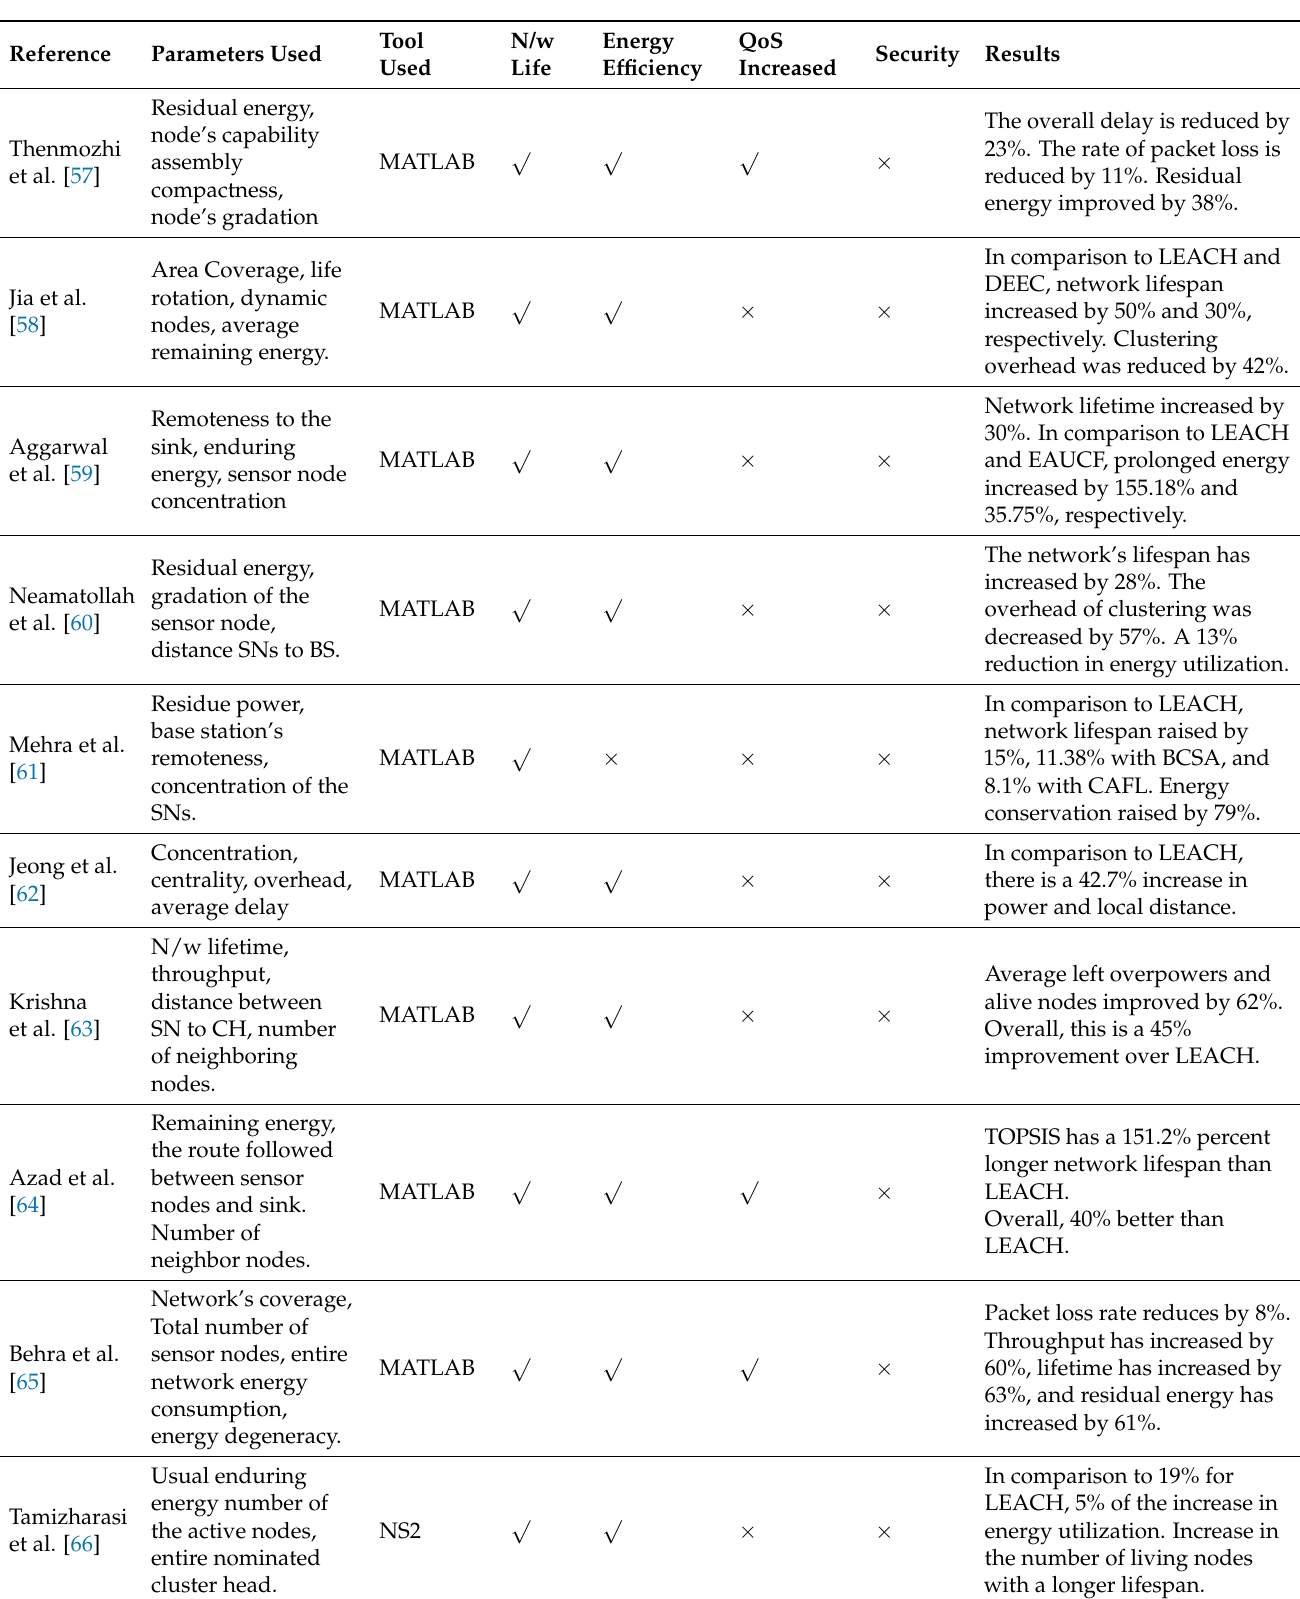
Table 3. Comparative analysis of various conclusions based on recent